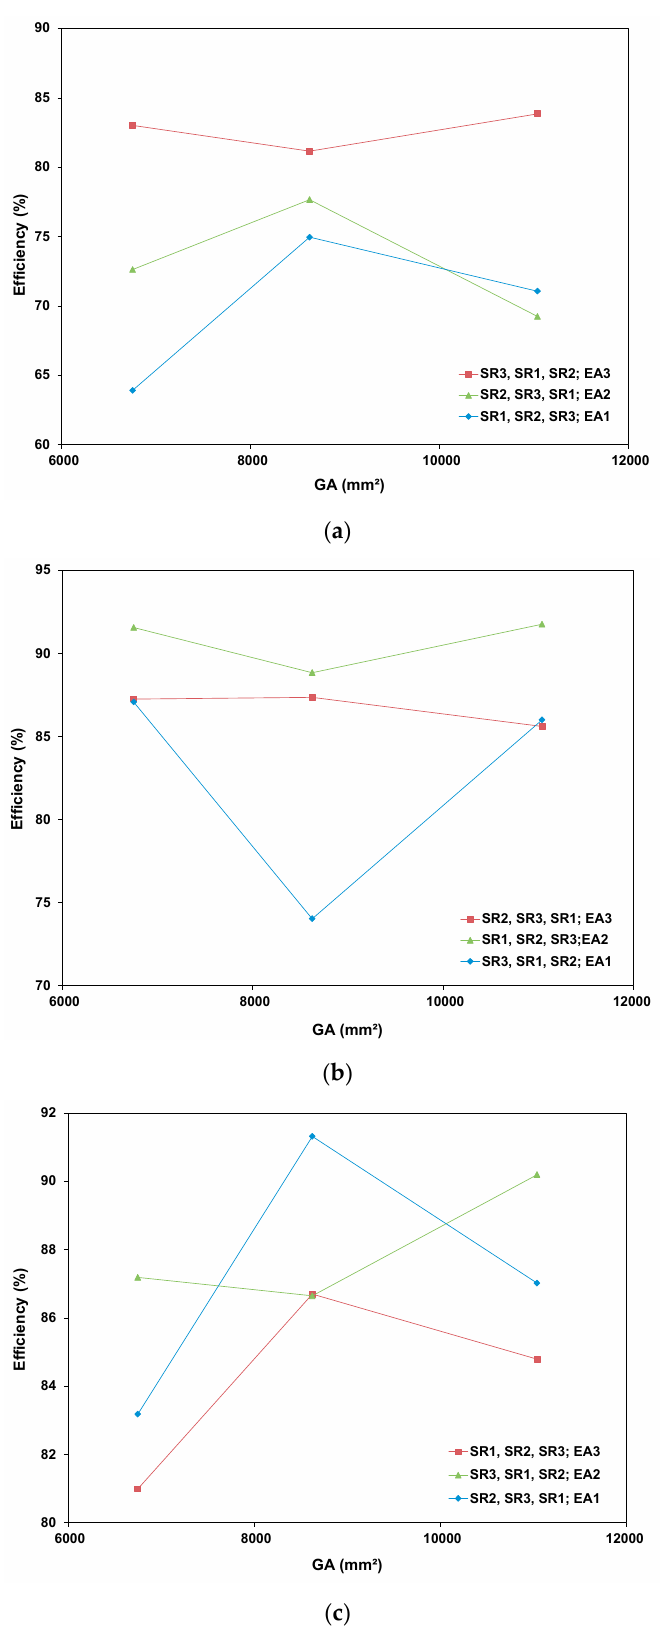
Figure 5. Relationship between efficiency and GA with different EA and SR: ( a ) at 10 kW, ( b ) at 13 kW, and ( c ) at 16 kW.